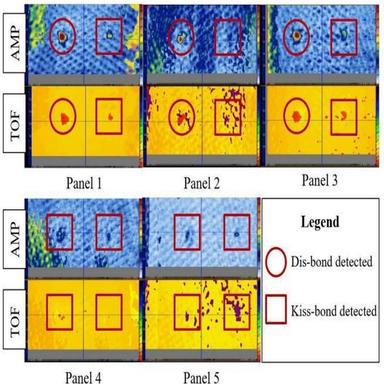
Summary of ultrasonic investigation results.